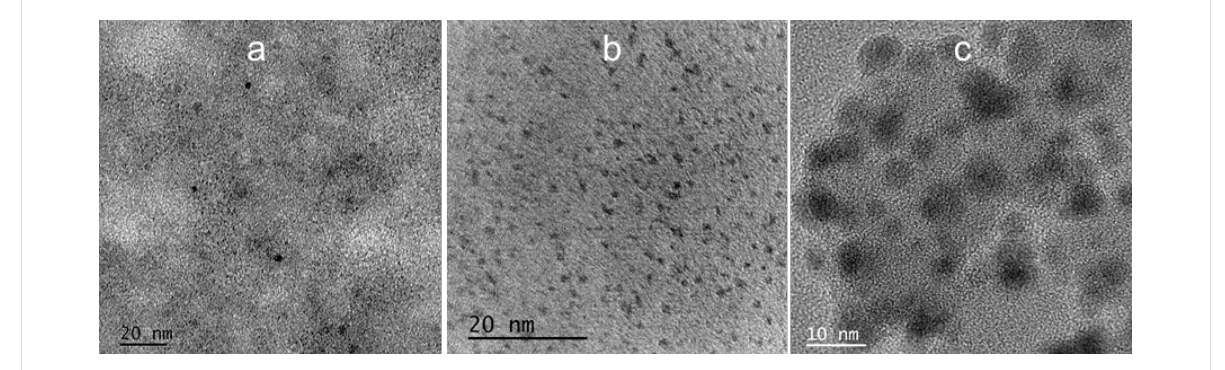
Figure 1: HRTEM images of C-dots obtained by carbonization in aqueous environment, using as carbon source a) tomatoes, b) carrots and c) tree leaves.